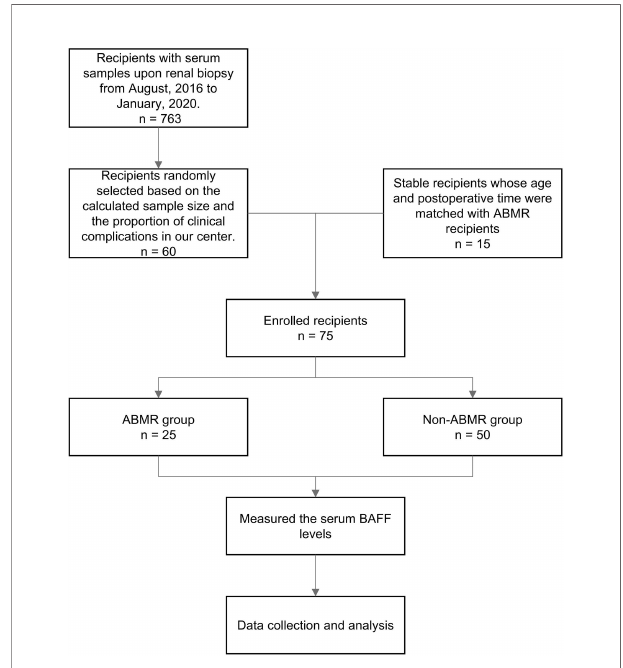
FIGURE 1 | The fl owchart of the diagnostic study. ABMR, antibody-mediated rejection; BAFF, B cell-activating